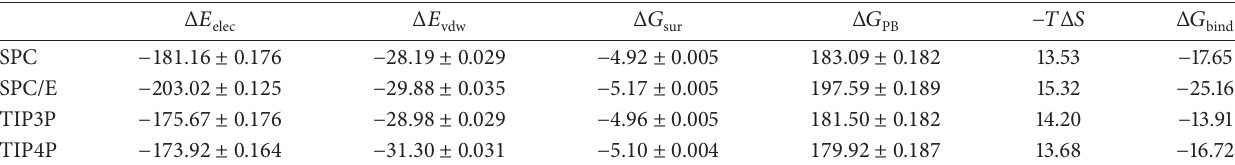
Table 3: Binding free energies (in units of kcal/mol) of Tamiflu to WT of A/H5N1 NA calculated by MM-PBSA method and AMBER99SB force field with different water models.